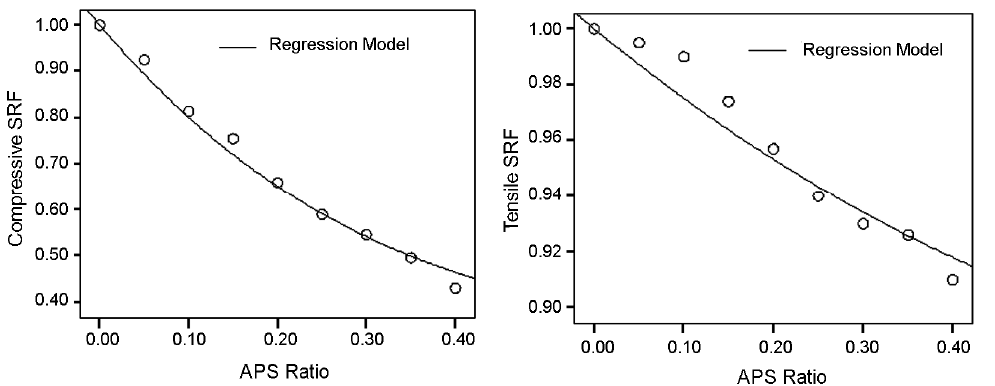
Fig. 5. Relationship of compressive and tensile SRF and APS